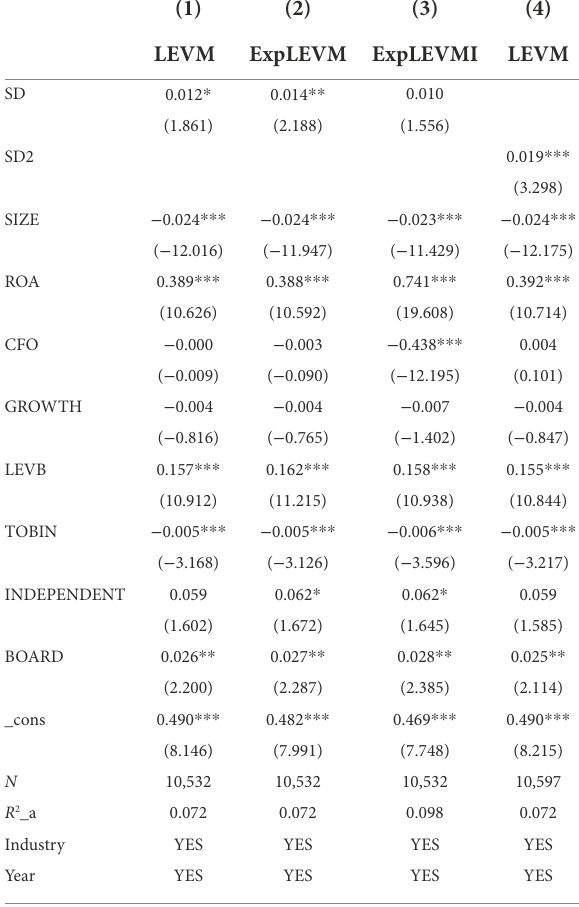
TABLE 14 Propensity score-matched post-sample